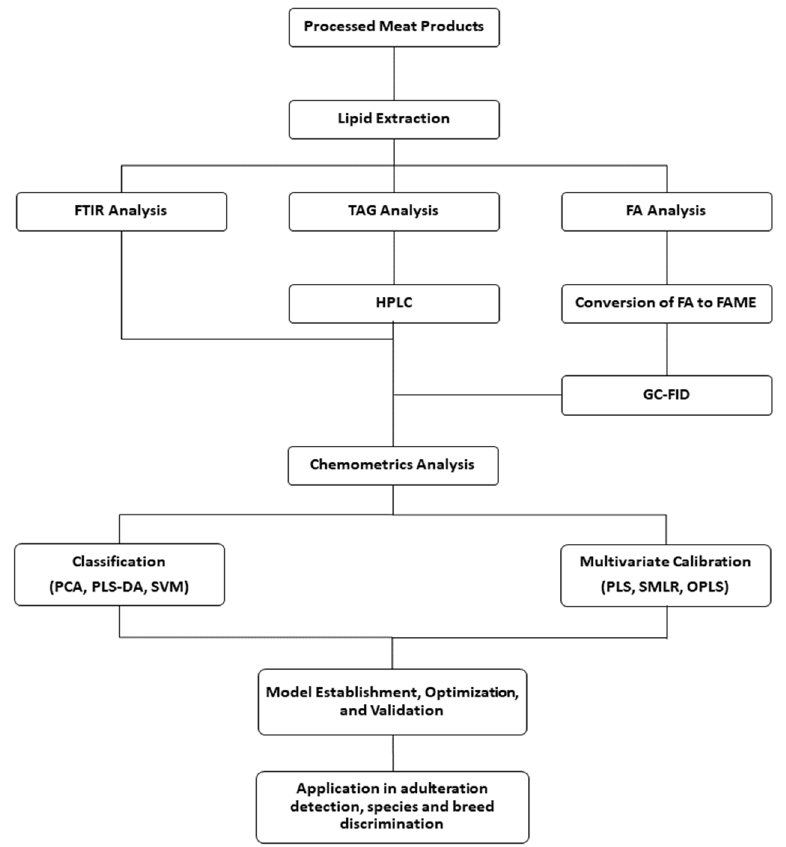
Figure 3. General lipidomic workflow in meat products analysis. TAG, triacylglycerol; FA, fatty acid; FAME, fatty acid methyl ester; GC-FID, gas chromatography with flame ionization Table 4. Summary of lipidomic application in chicken authentication. Type of samples and performance (limit of detection and discriminating accuracy) are included when available.